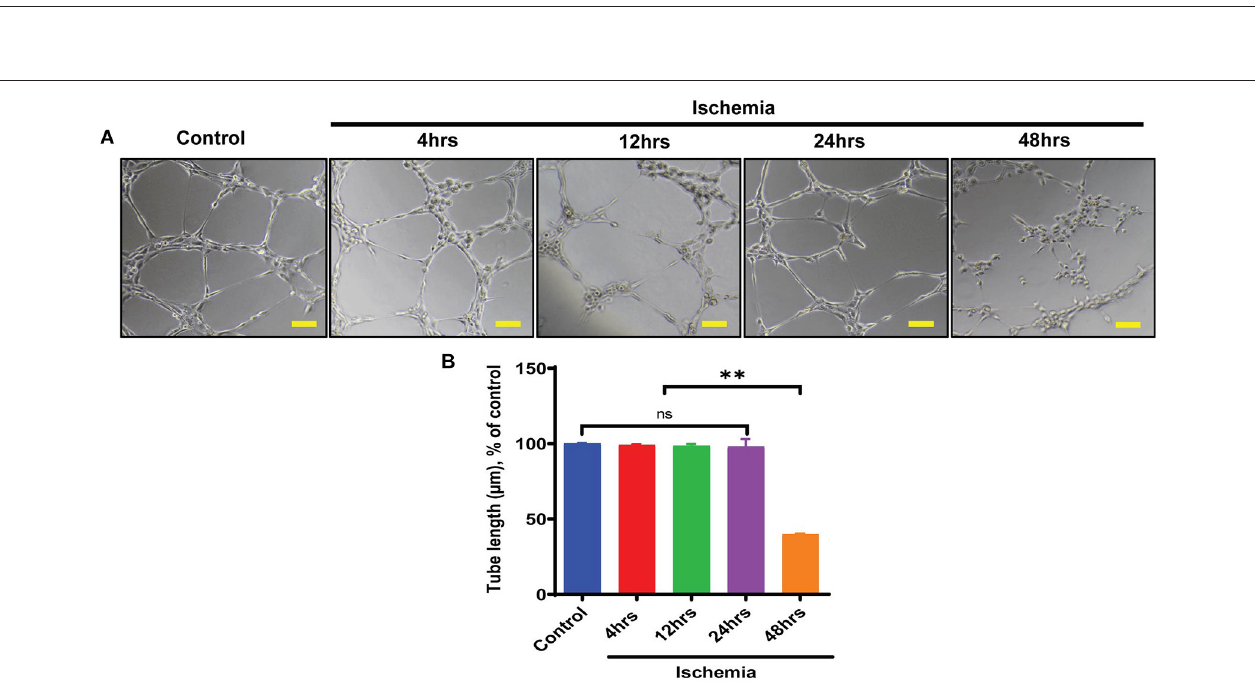
Frontiers in Cardiovascular Medicine | www.frontiersin.org